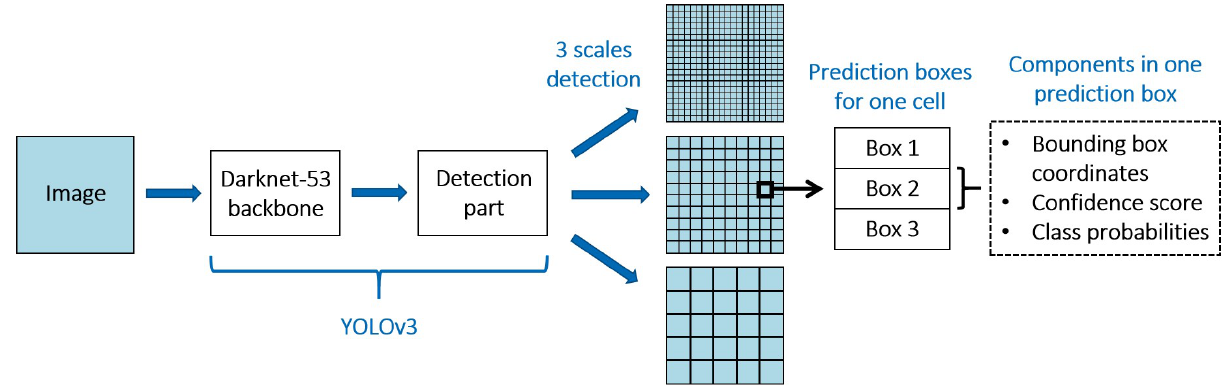
Figure 3. YOLOv3 and the components of its